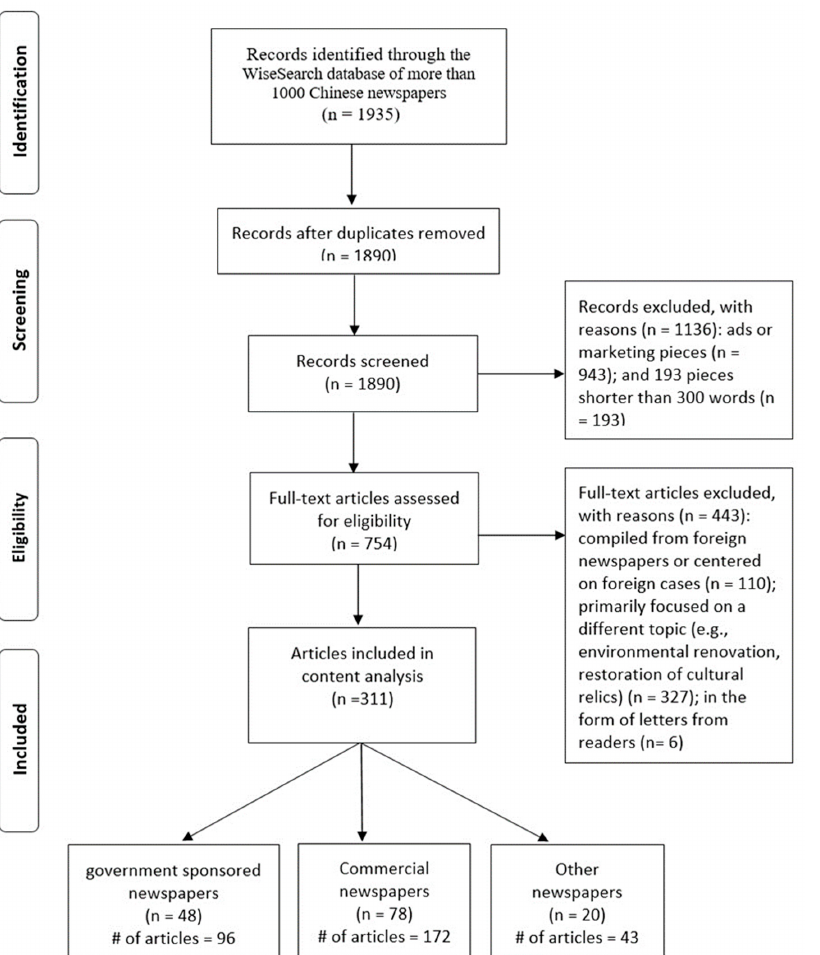
Figure 1. PRISMA flowchart of article inclusion. #. number of selected articles.